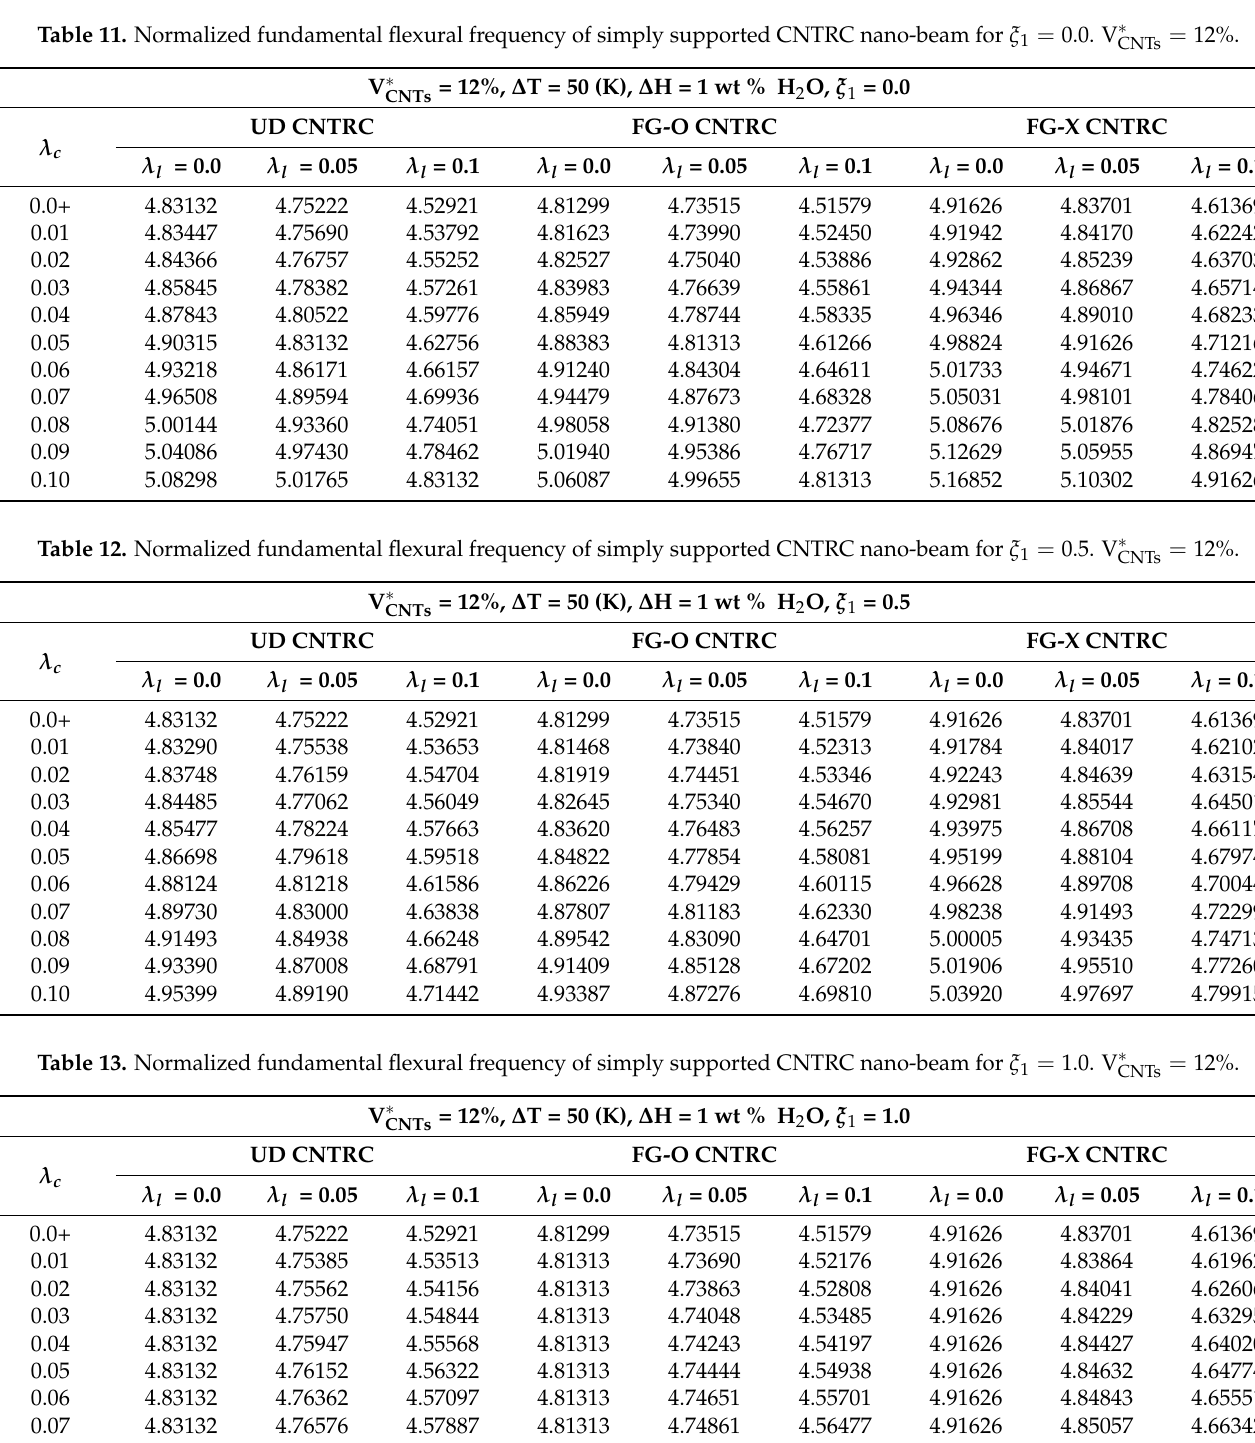
Table 11. Normalized fundamental flexural frequency of simply supported CNTRC nano-beam for ξ 1 = 0.0. V ∗